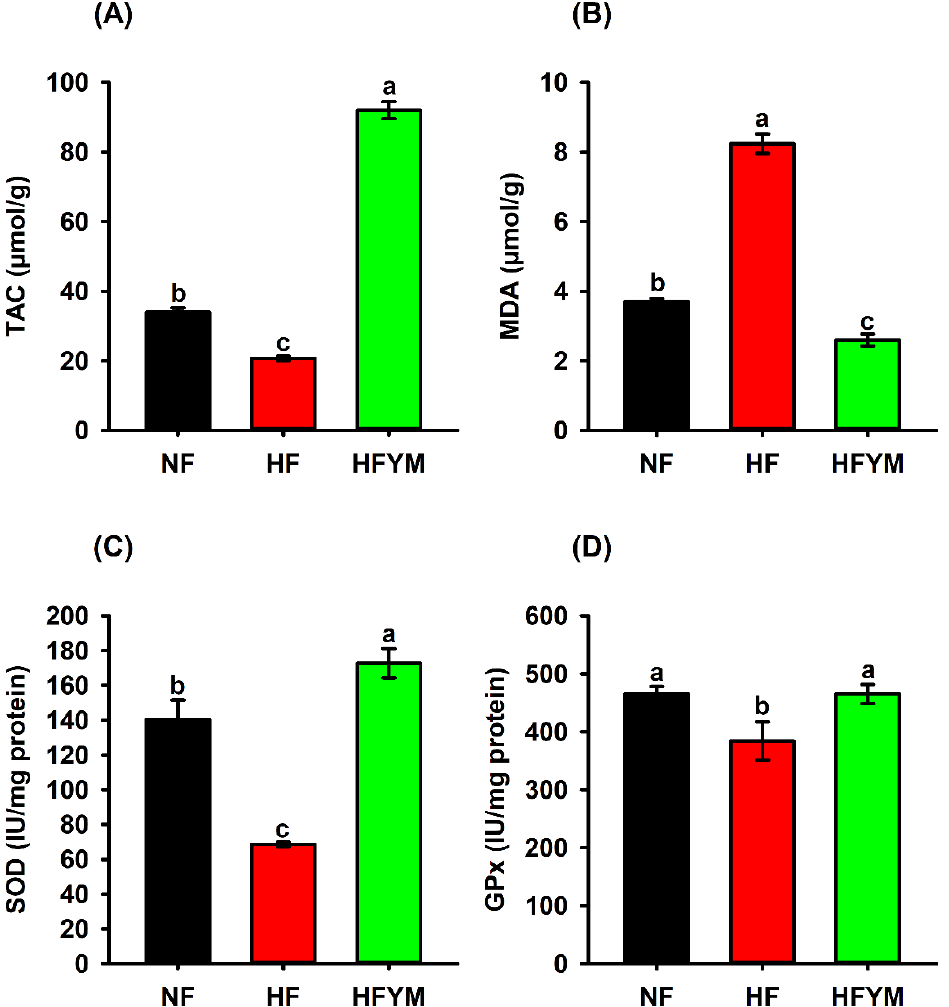
Figure 7. Total antioxidant capacity (TAC) ( A ), lipid peroxidation product — malondialdehyde — (MDA) ( B ), superoxide dismutase (SOD) ( C ), and glutathione peroxidase (GPx) ( D ) quantified in rat liver fed a normal-fat or high-fat diet and supplemented or not with yellow mombin. NF = normal-fat diet; HF = high-fat diet group; HFYM = high-fat diet group supplemented with yellow mombin. Data are represented with mean ± standard deviation. (a, b, c) Different lowercase letters in the bars indicate that there was a statistical difference among the groups (one way ANOVA followed by Tukey’s post-test, p ≤ 0.05).